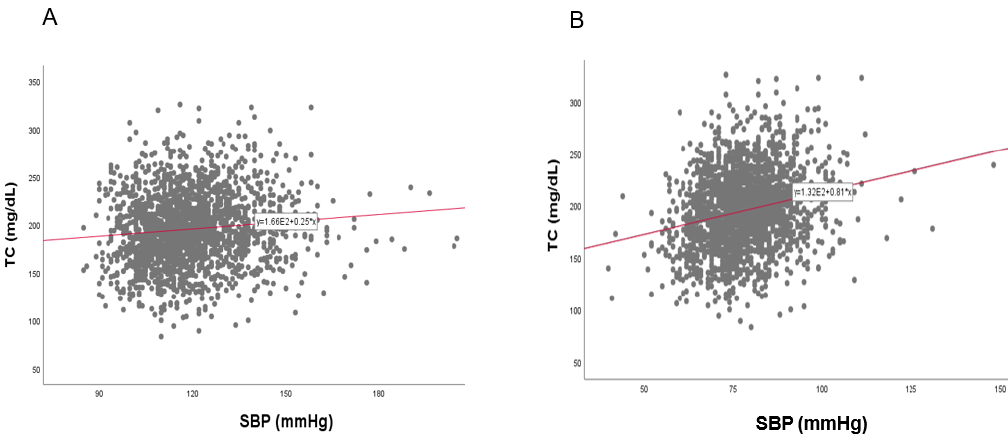
Figure 11. Pearson’s correlation analysis between total cholesterol (TC) and systolic blood pressure Figure 11. Pearson’ s correlation analysis between total cholesterol (TC) and systolic blood pressure Figure 11. Pearson’ s correlation analysis between total cholesterol (TC) and systolic blood pressure Figure 11. Pearson’ s correlation analysis between total cholesterol (TC) and systolic blood pressure (SBP, panel A ) and diastolic blood pressure (DBP, panel B ) in total population ( n = 4552). Panel A (SBP, panel A) and diastolic blood pressure (DBP, panel B) in total population ( n = 4552). Panel A (SBP, panel A) and diastolic blood pressure (DBP, panel B) in total population ( n = 4552). Panel A (SBP, panel A) and diastolic blood pressure (DBP, panel B) in total population ( n = 4552). Panel A showed a positive correlation (r = 0.134, p < 0.001) between SBP and TC. Panel B showed a positive showed a positive correlation (r = 0.134, p < 0.001) between SBP and TC. Panel B showed a positive showed a positive correlation (r = 0.134, p < 0.001) between SBP and TC. Panel B showed a positive showed a positive correlation (r = 0.134, p < 0.001) between SBP and TC. Panel B showed a positive correlation (r = 0.196, p < 0.001) between DBP and TC. correlation (r = 0.196, p < 0.001) between DBP and TC. correlation (r = 0.196, p < 0.001) between DBP and TC. correlation (r = 0.196, p < 0.001) between DBP and TC.